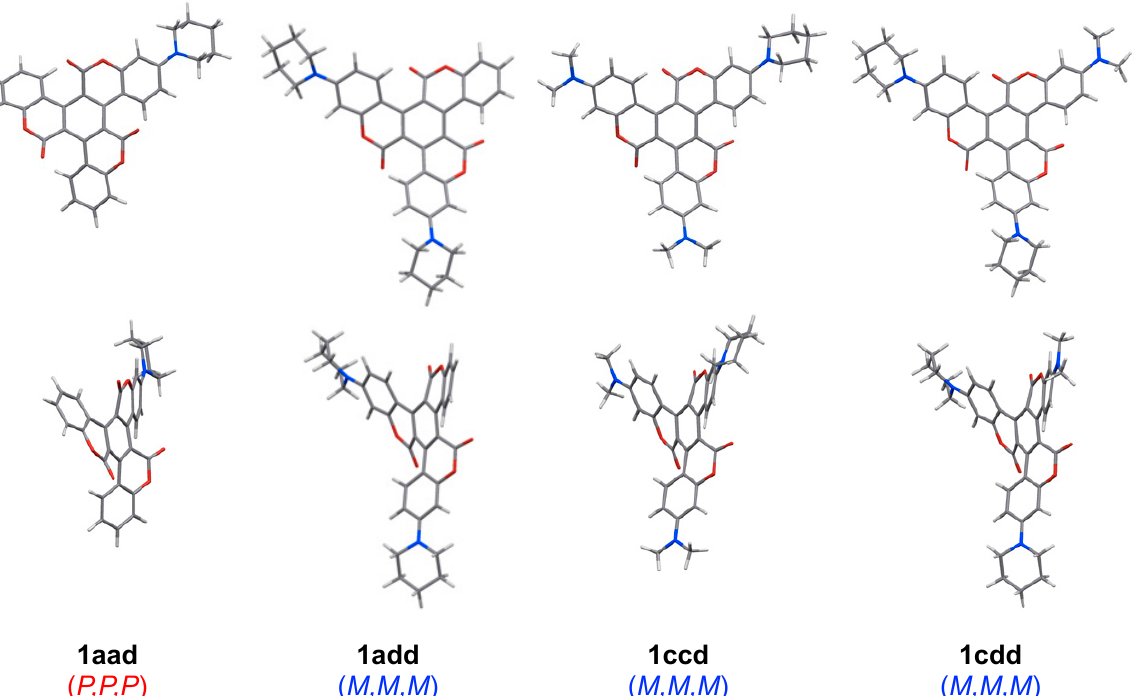
Figure 2. Optimized structures of 1aad , 1add , 1ccd , and 1cdd at the RB3LYP/6-31G level. The maximum transition state energy for the isomerization between ( P,P,P ) and ( M,M,M )- 1A was estimated to be 9.46 kcal/mol at the ω B97-XD/6-31G(d) level of theory. Even in the case of 1C , bearing N -containing donor groups, the corresponding energy was 8.7 kcal/mol. This indicates that these derivatives underwent continuous flipping in diluted solutions. Furthermore, all triskelion-shaped compounds adopted a Janus-type structure and presented two distinct molecular π -surfaces (Figure 3). Based on the helical triskelion-shaped framework, the electrostatic potential mapping of these compounds demonstrated that the outer phenyl groups on the front surface of 1 were positively charged (blue) and the three electron-withdrawing carbonyl groups on the back face were nega- tively charged (red), regardless of the molecular symmetry. Thus, these molecules exhibit out-of-plane anisotropy via the central benzene ring from the positive area on the front to the negative area on the back face. The estimated dipole moments of the derivatives bearing donor groups reached 7.83 Debye, which is higher than those of bowl-shaped sumanene [36] and Janus-type subphthalocyanine [37]. Interestingly, the dipole moments of asymmetrical derivatives 1aad , 1add , 1ccd , and 1cdd were also showed large owing to the triskelion-shaped framework. We believe that this Janus-type anisotropy is beneficial for nanomaterials applicable in molecular recognition that operates through molecular rearrangement control [38].